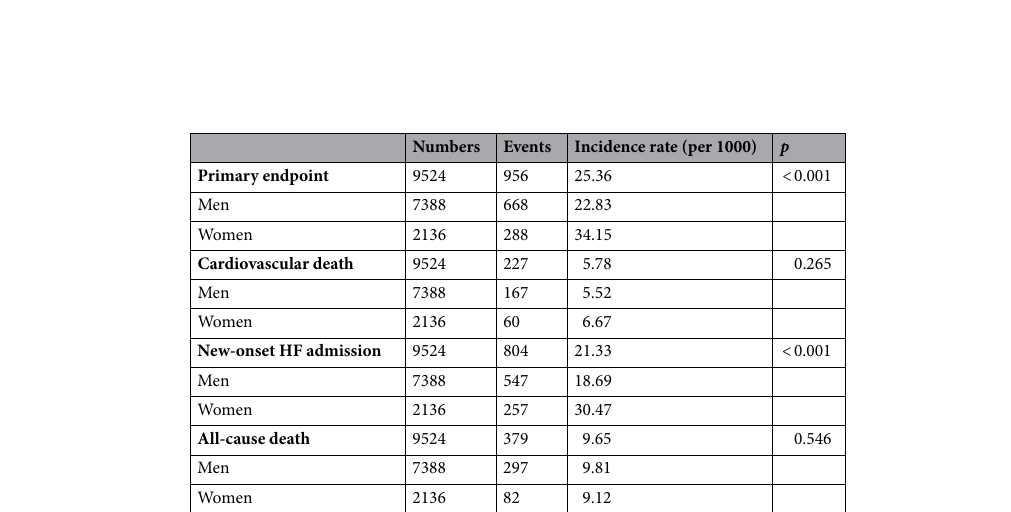
Figure 1. Kaplan–Meier curve of the cumulative incidence of clinical events in the original cohort of patients with hypertrophic cardiomyopathy. ( A ) The primary endpoint of cardiovascular death or new-onset HF admission; ( B ) cardiovascular death; ( C ) new-onset HF admission; ( D ) all-cause death. CV cardiovascular, HF heart failure.